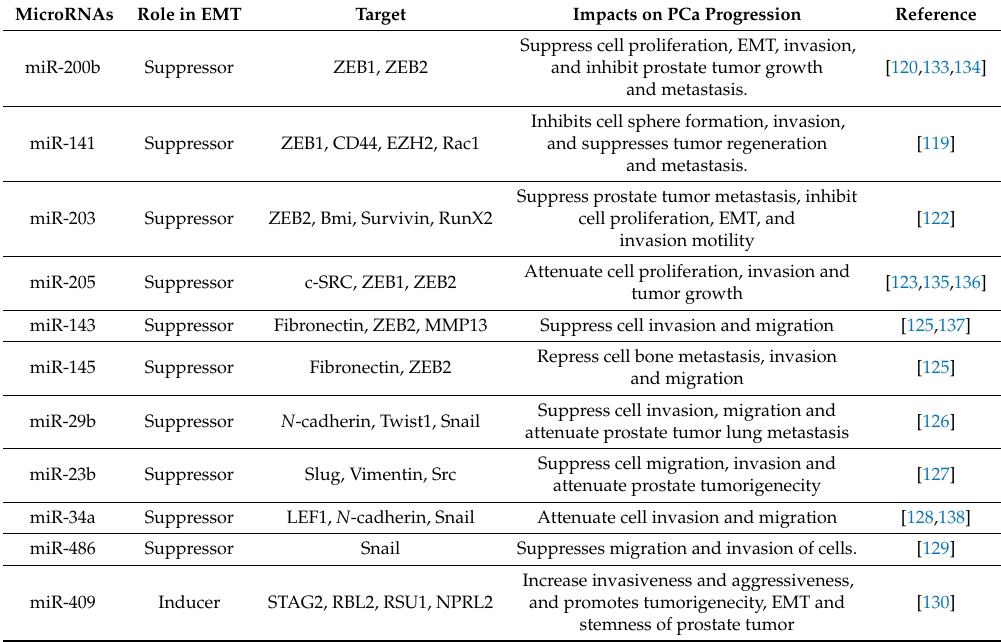
Table 2. MicroRNAs involved in the EMT and metastatic progression of